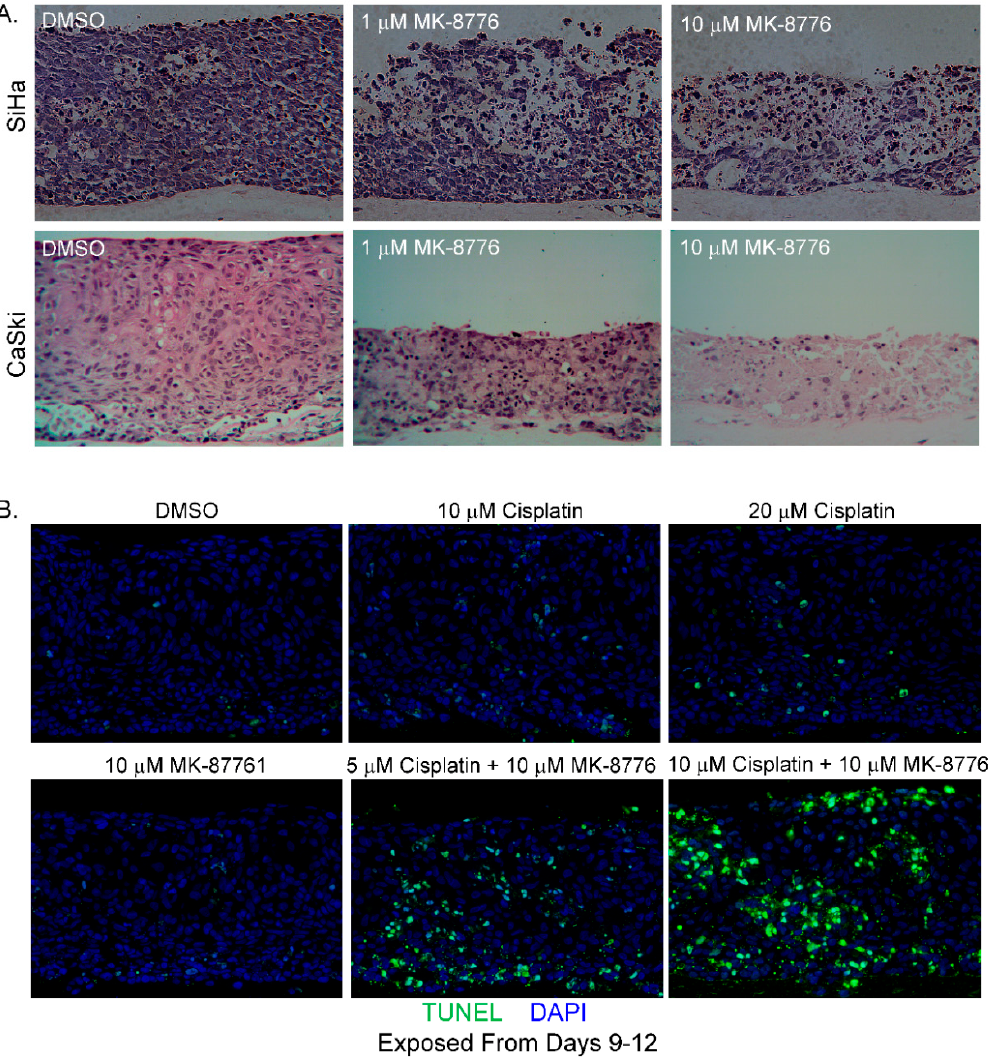
Figure 8. MK-8776 is cytotoxic to raft cultures of cervical cancer cell lines and increases their sensitivity to cisplatin. ( A ) Hematoxylin and eosin staining of tissue sections from SiHa and CaSki raft cultures, exposed to DMSO or MK-8776 at indicated concentrations from days 7 to 13 (SiHa) or 6–12 (CaSki). Cultures were harvested on last days of treatment. Cytotoxicity is evident from the degenerated tissues. ( B ) TUNEL assay showing apoptotic nuclei (green) in raft cultures of CaSki exposed to MK-8776, cisplatin, or both at indicated concentrations from days 9 to 12. Images were captured with 20× objective.